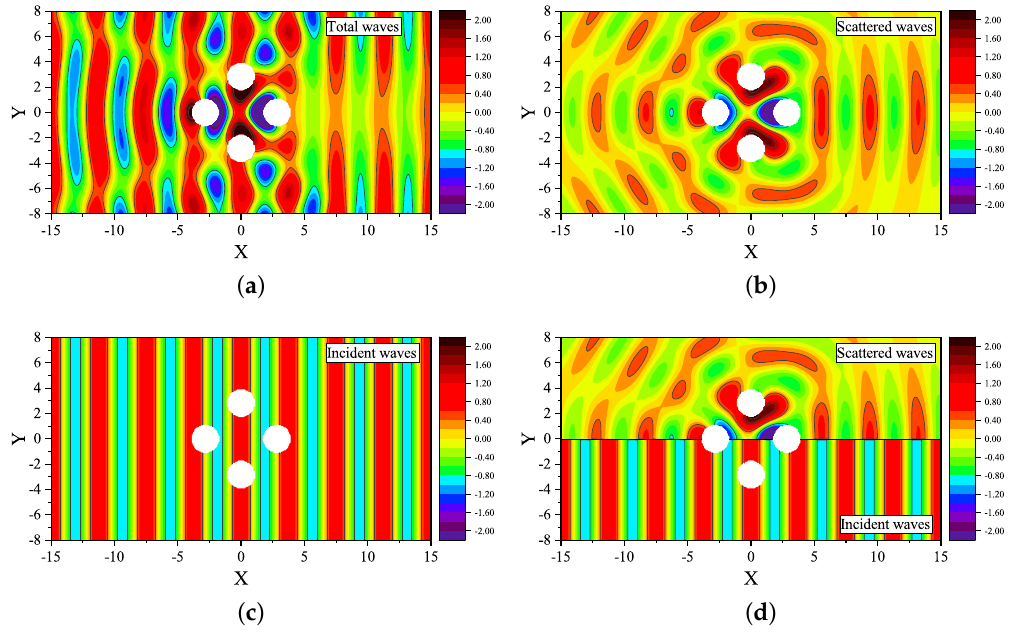
Figure 6. The wave elevation η p / η 0 considering the initial phase at k 0 a = 1.68: ( a ) total waves; ( b ) scattered waves; ( c ) incident waves; ( d ) scattered waves and incident